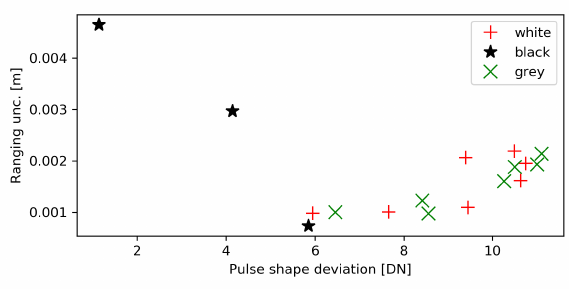
Figure 12. VZ-2000i ranging uncertainty vs. deviation for a constant range of 60m .